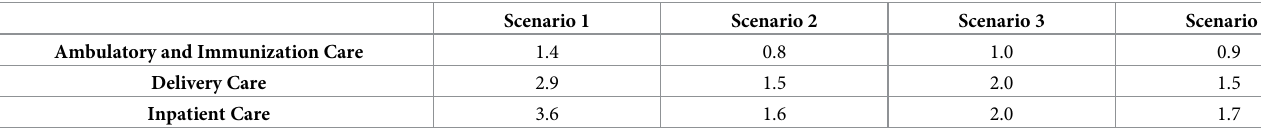
Table 4. Median travel time to reach health facilities by travel